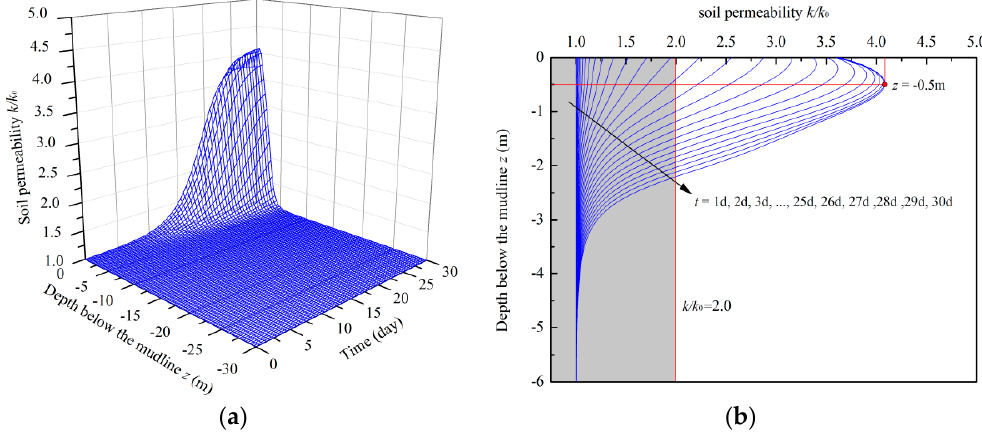
Figure 7. Variations of the soil porosity with the increase of wave acting time: ( a ) Diagram of three-dimensions; ( b ) diagram of two-dimensions. J. Mar. Sci. Eng. 2019 , 7 , x FOR PEER REVIEW